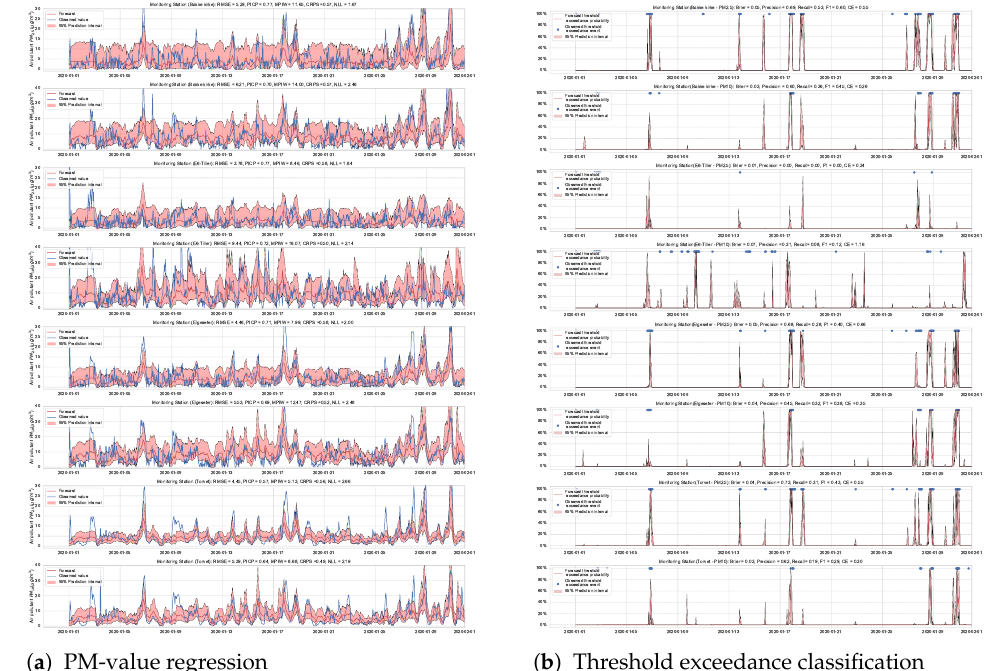
Figure A11. Deep probabilistic forecast of air quality using deep ensemble at four monitoring stations.